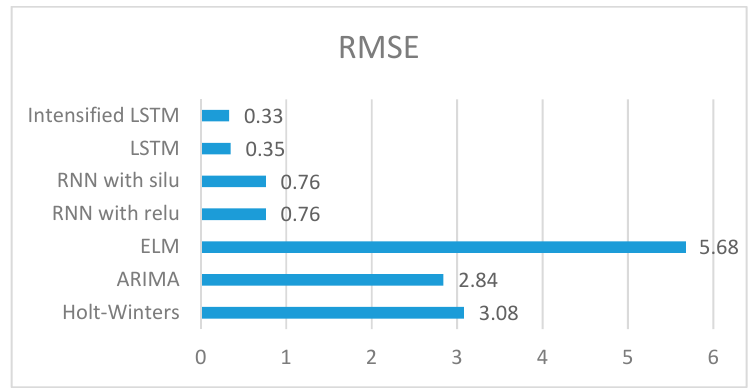
Figure 11. Comparing the RMSE of different prediction models.